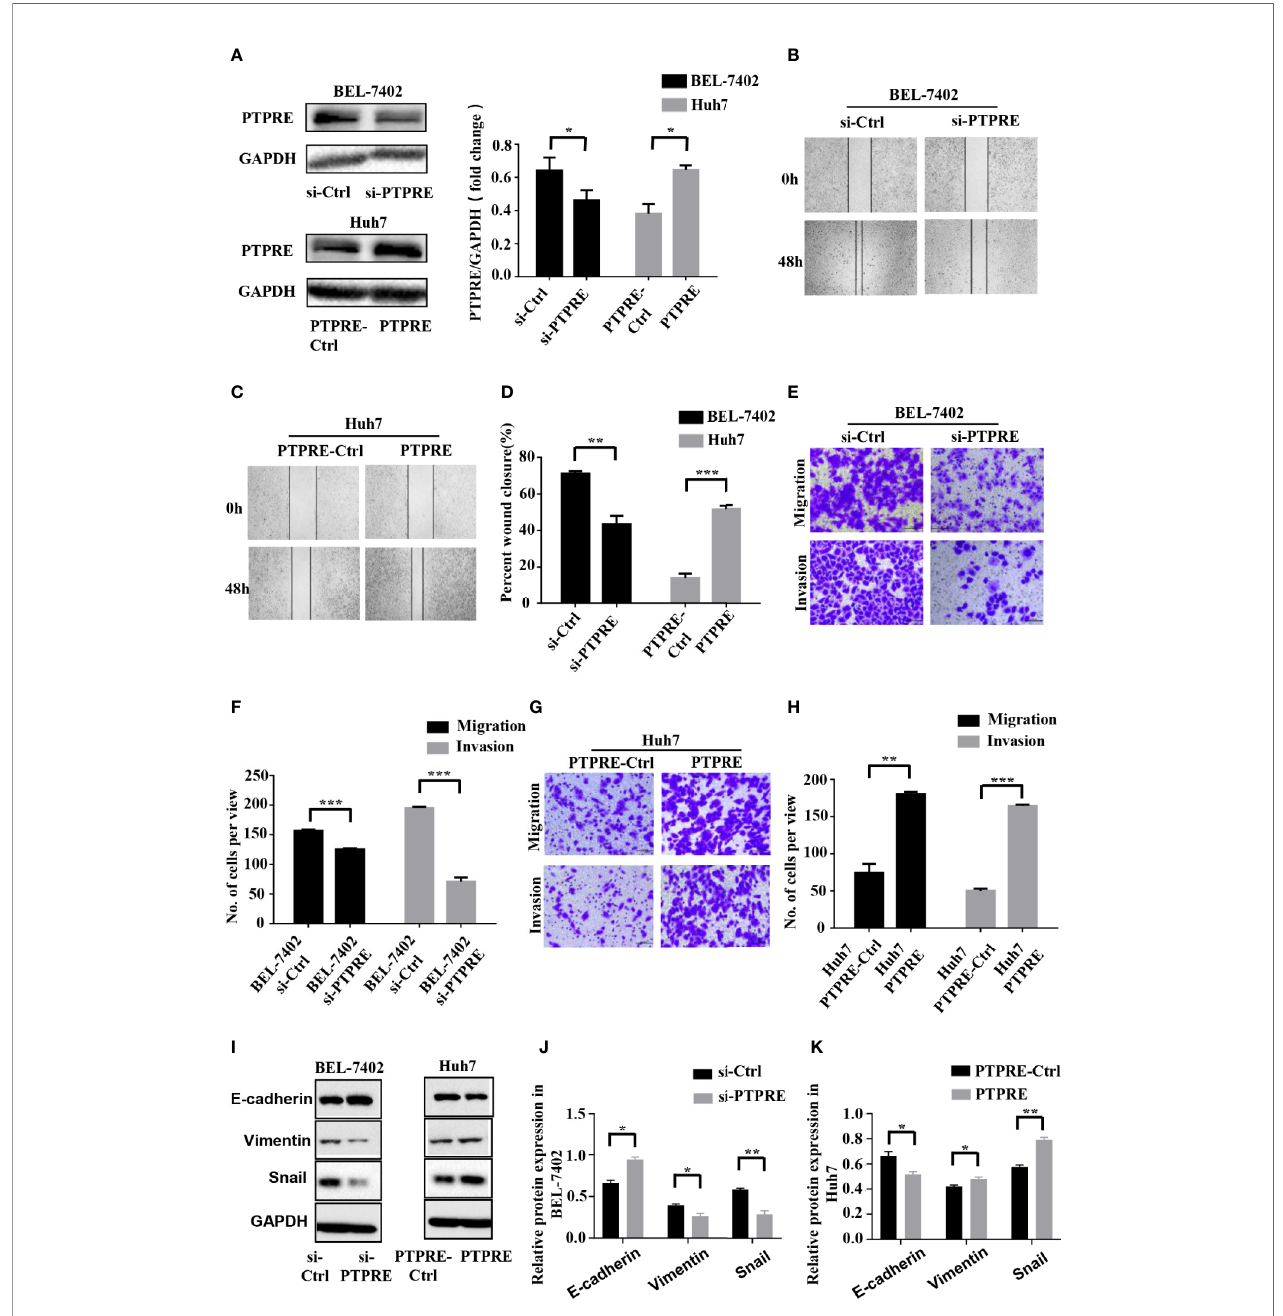
FIGURE 4 | PTPRE induces migration and invasion of HCC cells. (A) Western blot assays of PTPRE in BEL-7402 and Huh7 cells after knocking down and overexpressing PTPRE separately. (B – D) The representative images of wound healing assay were obtained and the percentages of wound closure were calculated. (E, F) Transwell migration and invasion assays of BEL-7402 cells. (G, H) Transwell migration and invasion assays of Huh7 cells. (I – K) Western blot assay of protein in EMT. *P < 0.05; **P < 0.01; ***P <